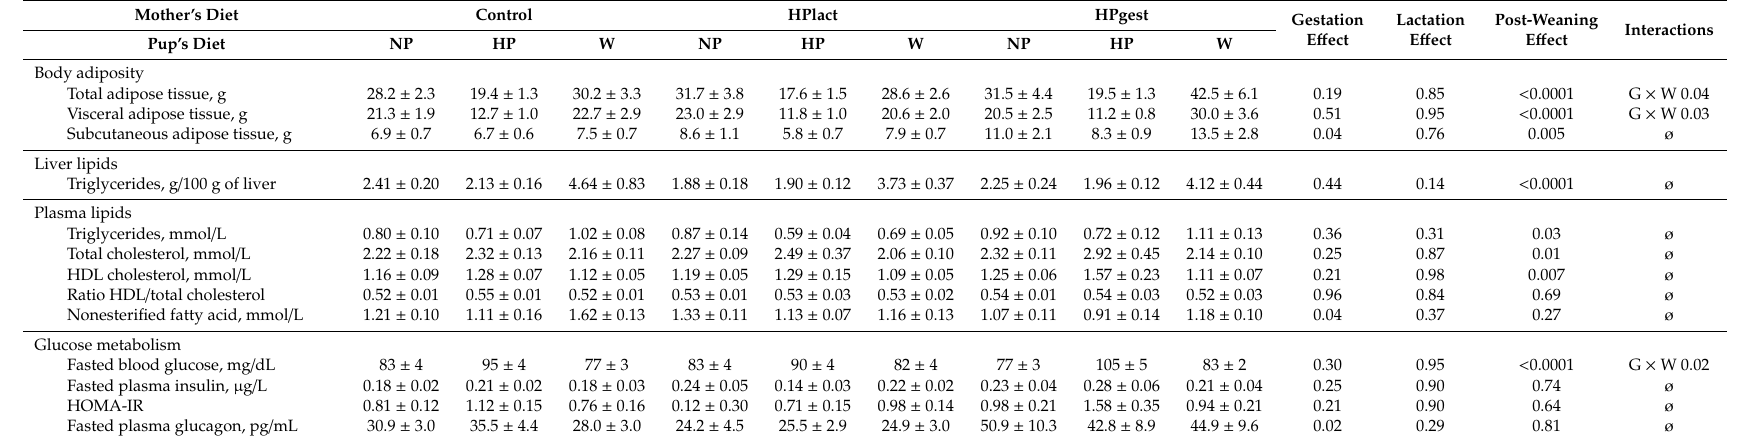
Table 1. Body adiposity and liver triglycerides at PND70, plasma lipids and glucose metabolism parameters of fasted female rat pups at